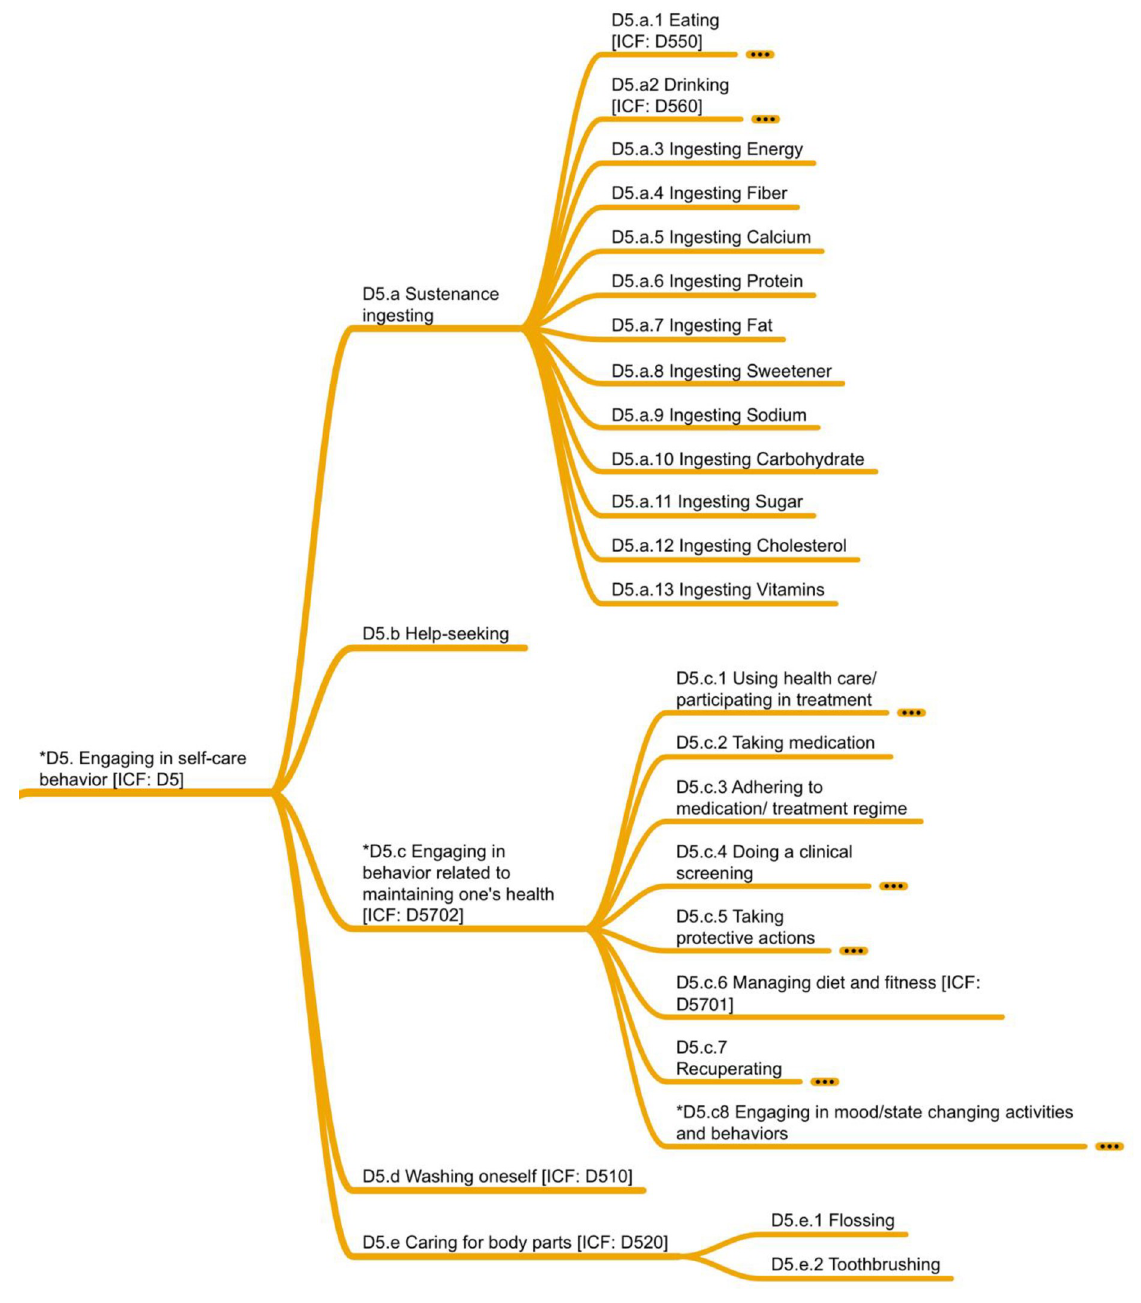
Fig 7. D5 domain on engaging in self-care